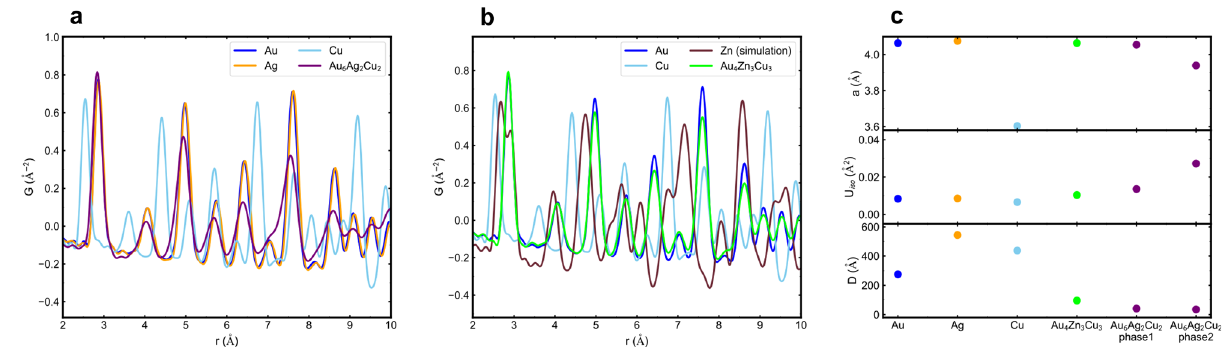
Fig. 5 Results of atomic PDF analysis. Overlapping plot of single metal and alloy nanoparticles zoomed in to the low-r region. a Au 6 Ag 2 Cu 2 , b Au 4 Zn 3 Cu 3 . c Summary of fi tting results. “ a ” is the lattice constant, “ Uiso ” is the isotropic ADPs, and “ D ” is the diameter of the crystallites. There are two phases in Au 6 Ag 2 Cu 2 , labeled as “ phase1 ” and “ phase2 ”